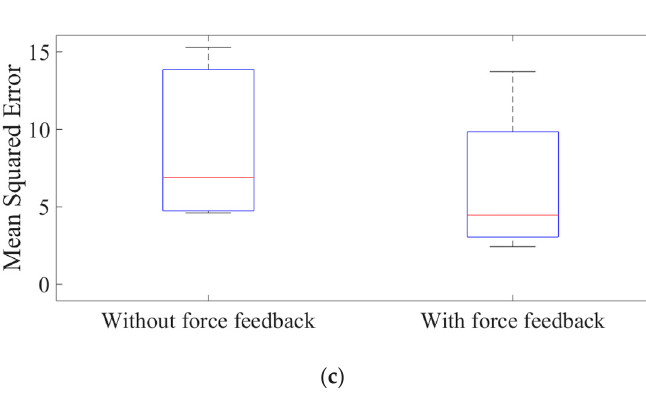
Figure 15. The mean squared error of subject one. ( a ) Subject one (female, age of 26); ( b ) subject two (male, age of 25); ( c ) subject three (male, age of 27).